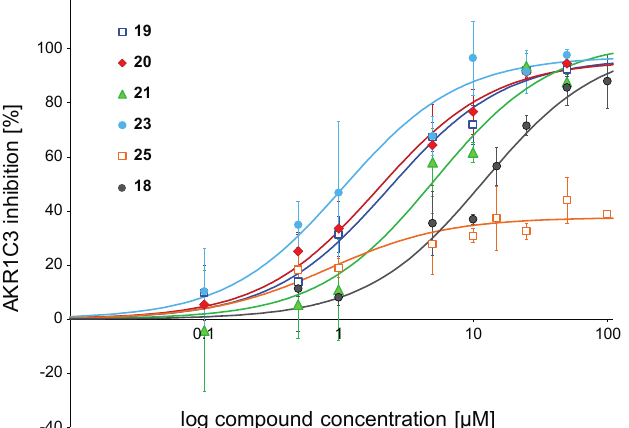
Figure 2. IC 50 curves for selected chalcones. Shown is the inhibition of the ∆4-androstene-3,17-dione reduction catalysed by AKR1C3 at increasing compound concentrations. Data were fitted to the one-site ligand binding equation of the SigmaPlot Kinetics module. Symbols for compounds are shown in the plot. Experiments were performed in triplicates, and mean values ± SD are shown.